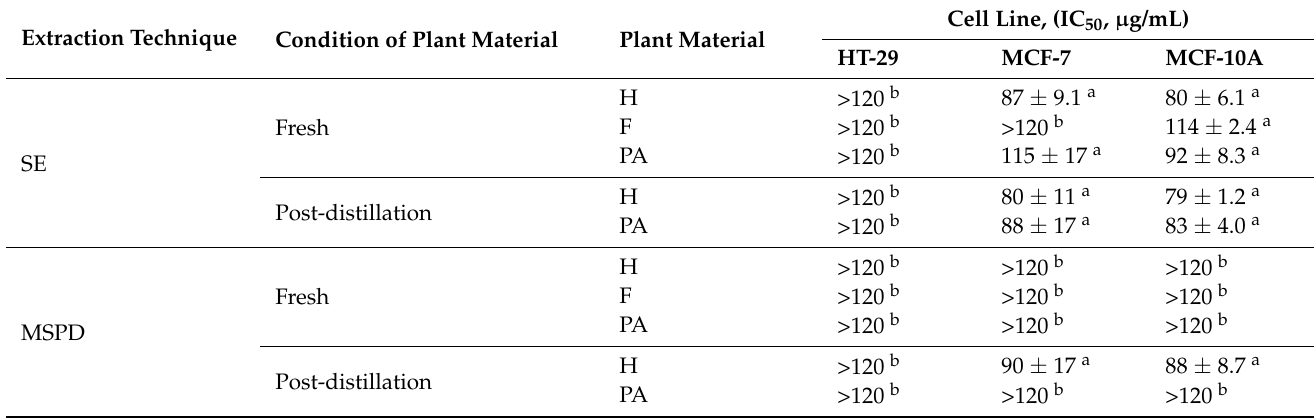
Table 4. Cytotoxic activity of extracts on HT-29, MCF-7 and MCF-10A cell